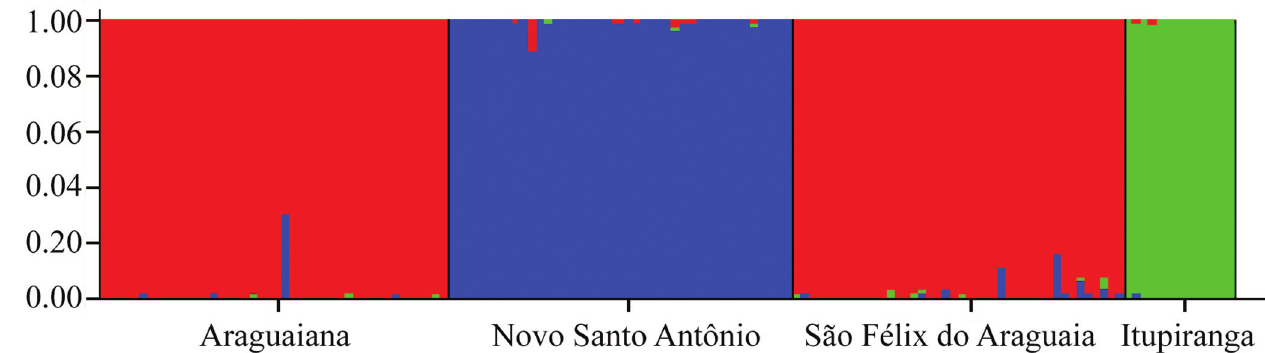
Fig. 3. Genetic contribution profile of each stock considering k = 3 for each subject analysis. Each individual is represented by a thin vertical line, which is partitioned into K segments that represent its estimated population group membership fractions. Black lines separate individuals from geographical site locations. The red, blue and green colors represent each stock (gene